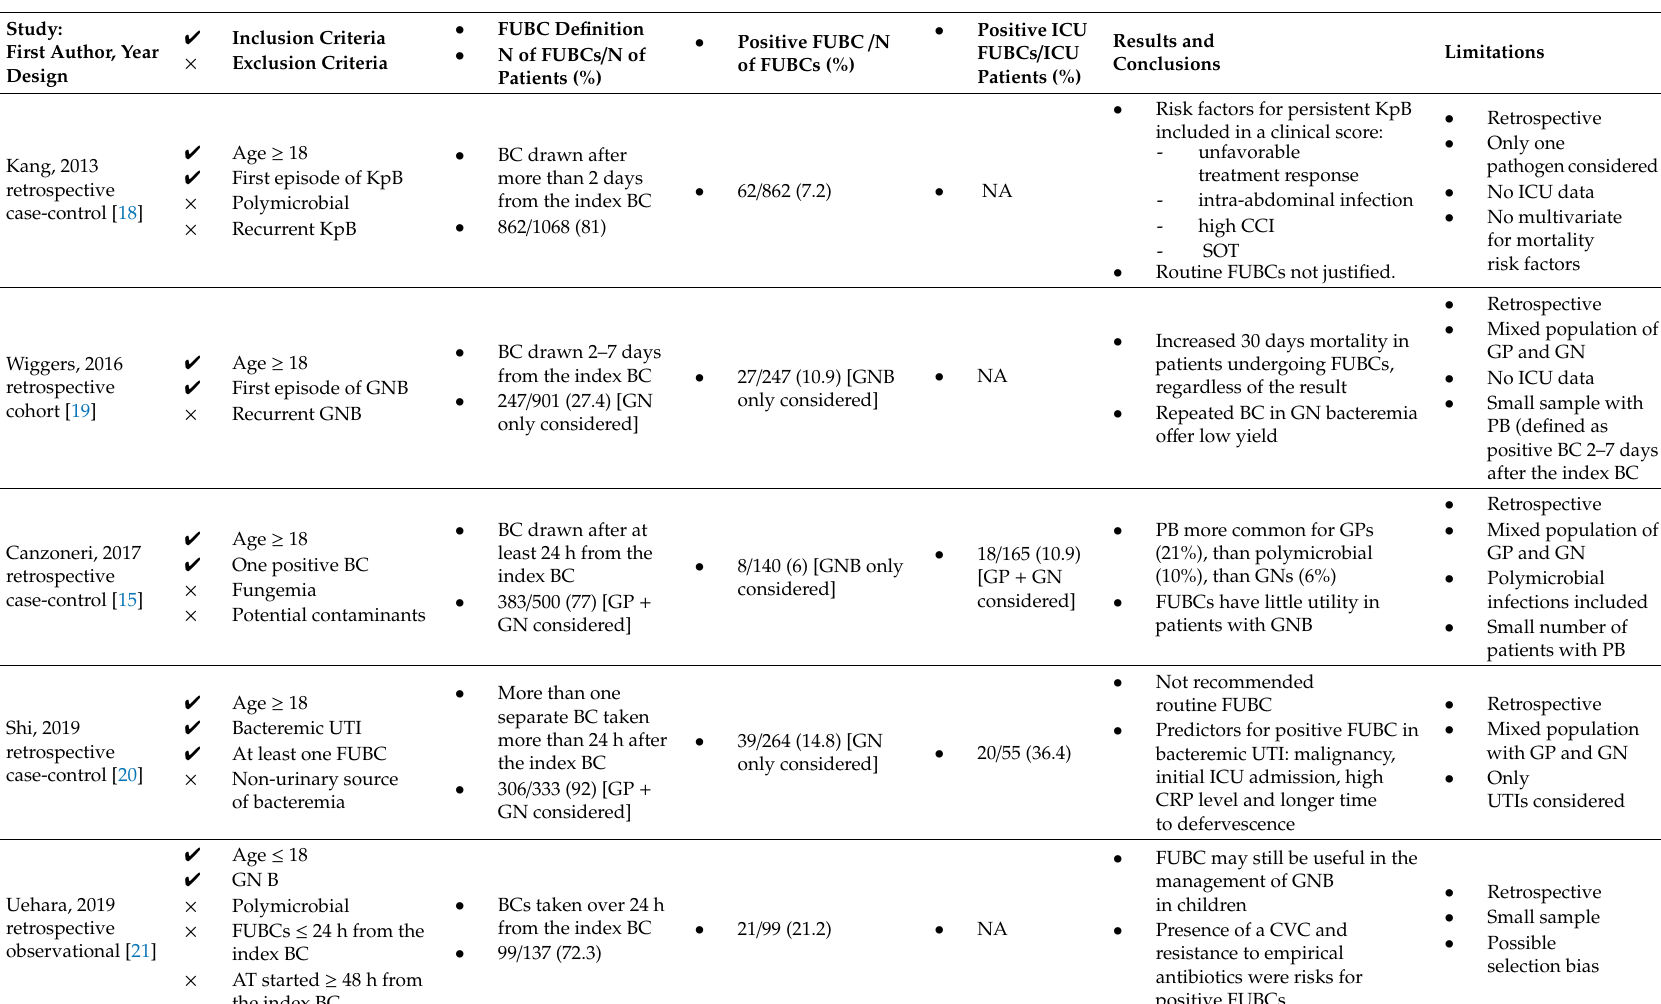
Table 1. Summary of the main studies on follow up blood cultures (FUBCs) in Gram negative